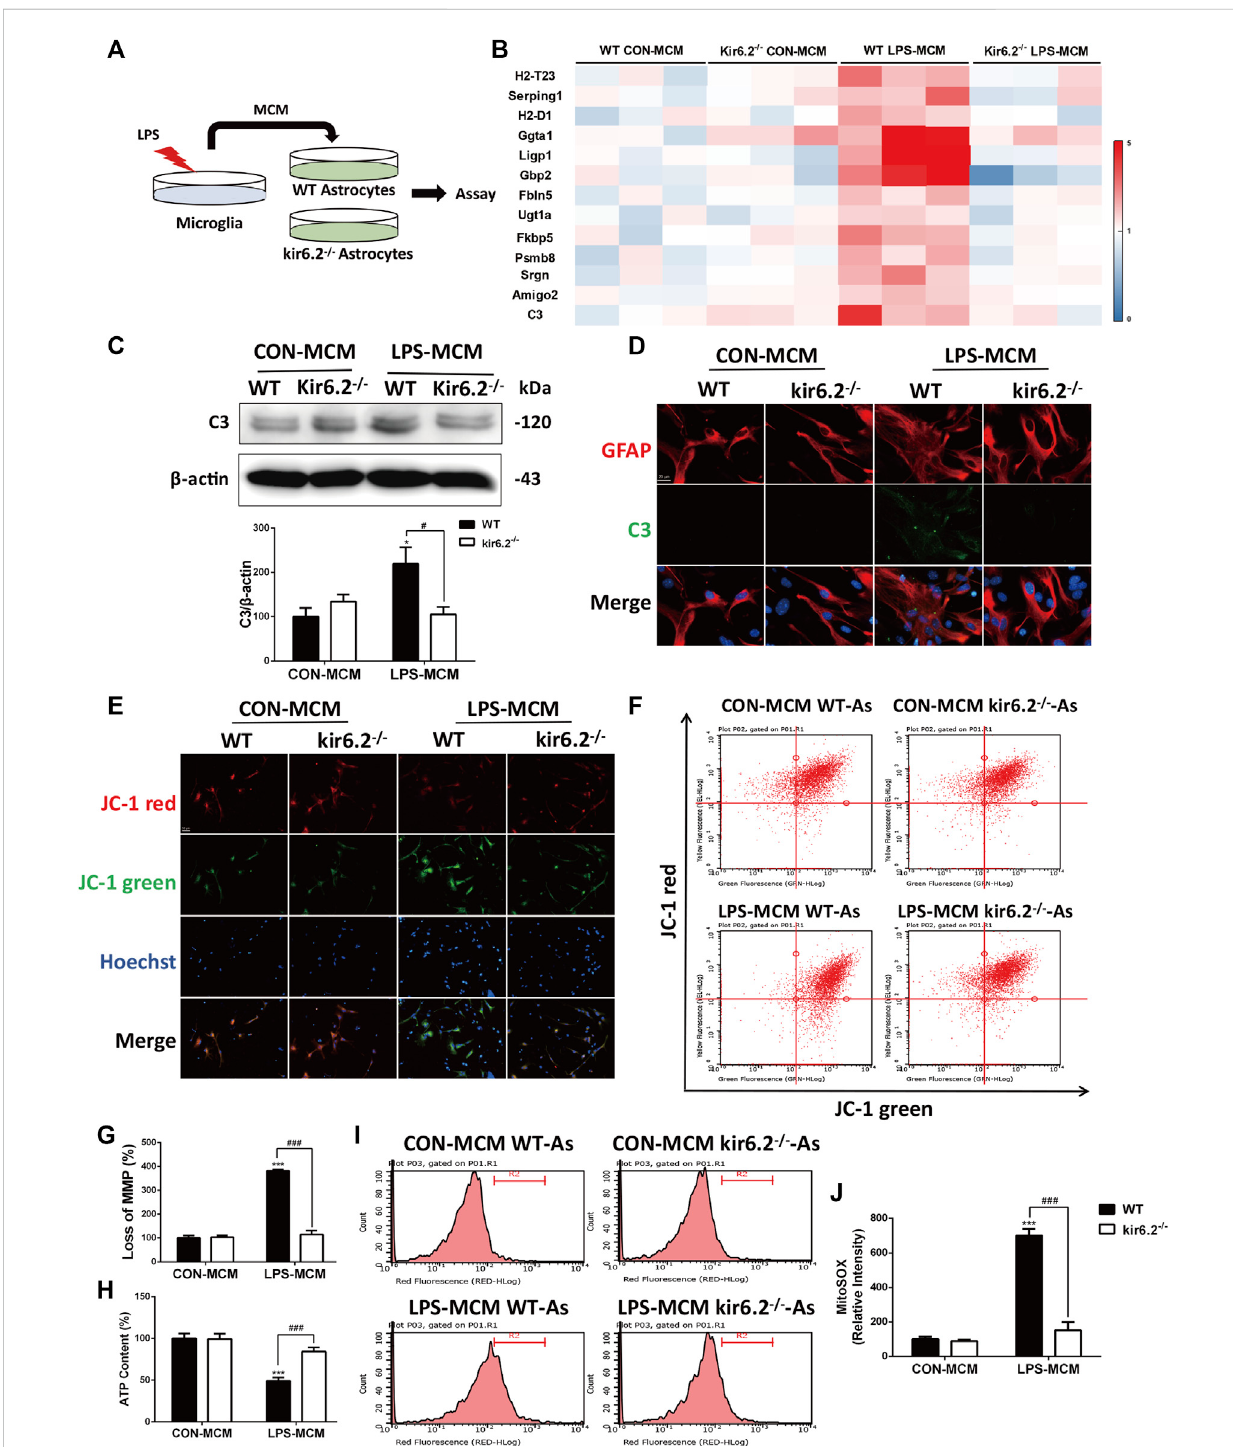
FIGURE 6 Kir6.2-de fi cient astrocytes are resistant to neurotoxic A1-like phenotype in vitro . (A) Protocol of treatment for (B – J) . Primary microglia from WT mice were stimulated with 100 ng/mL LPS for 24 h to collect the MCM. For primary astrocytes cultures, the MCM was diluted at a ratio of 1:3 to incubate the primary astrocytes from WT and kir6.2 − / − mice for 24 h. (B) Heat map comparing the mean expression of A1-speci fi c transcripts in astrocytic RNA samples by RT-PCR. (C) Expression of C3 in primary astrocytes detected by Western blotting and its densitometric analysis. (D) Immuno fl uorescent stainingsofC3(green)andGFAP(red)inprimaryastrocytes. (E) RepresentativeimagesofJC-1staininastrocyteswereobservedbyconfocalmicroscopy. Hoechst stains nucleus (blue). (F) Flow cytometric analysis of astrocytes stained with JC-1 fl uorescent probe. (G) Quanti fi cation of MMP loss in JC-1 staining measured by fl ow cytometry. (H) ATP contents of astrocytes were analyzed. (I) Astrocytes were stained with MitoSOX fl uorescent probe and analyzed by fl ow cytometry. (J) Quanti fi cation of the mitochondrial ROS by MitoSOX staining. Data were analyzed using two-way ANOVA. * p < 0.05 and *** p < 0.001 vs. corresponding CON-MCM group. # p < 0.05 and ### p < 0.001 vs. WT LPS-MCM group. Values are presented as means ± SEM from three independent